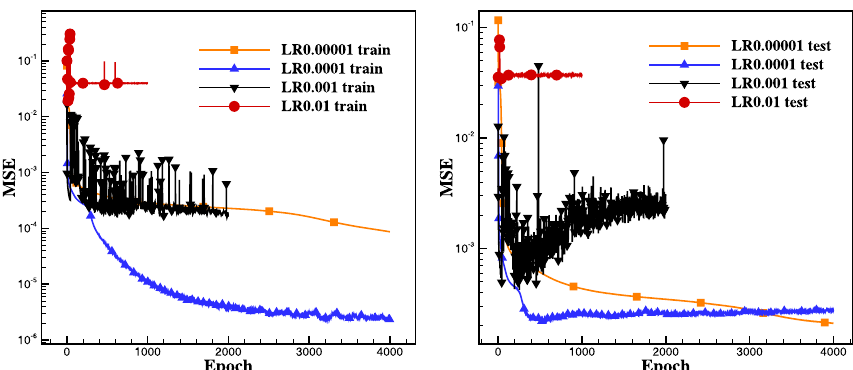
Fig. 17 MSE convergence histories of CNN‑2 with different learning rates in training dataset (left) and test dataset (right)